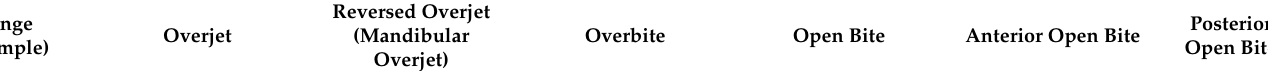
Table 2. Prevalence of overjet, reversed overjet, overbite, and open